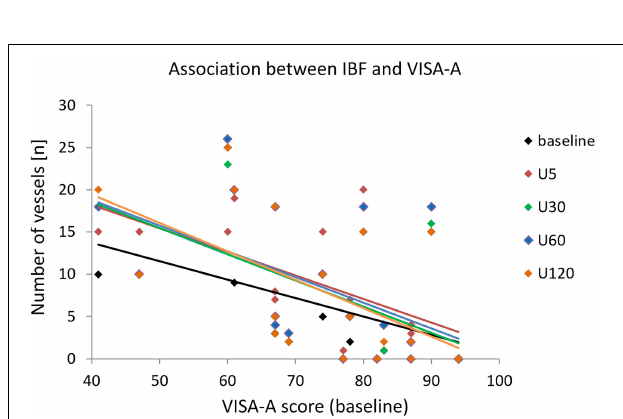
FIGURE 5 | Mean IBF changes in response to exercise (difference to baseline) for symptomatic (sym) and asymptomatic (asym) ATs over the course of time (Upre–U120).